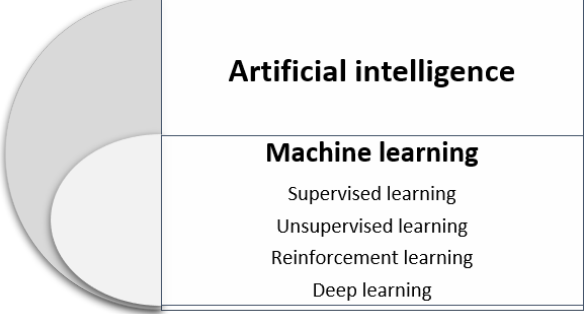
Figure 4. Classification of machine-learning methods.